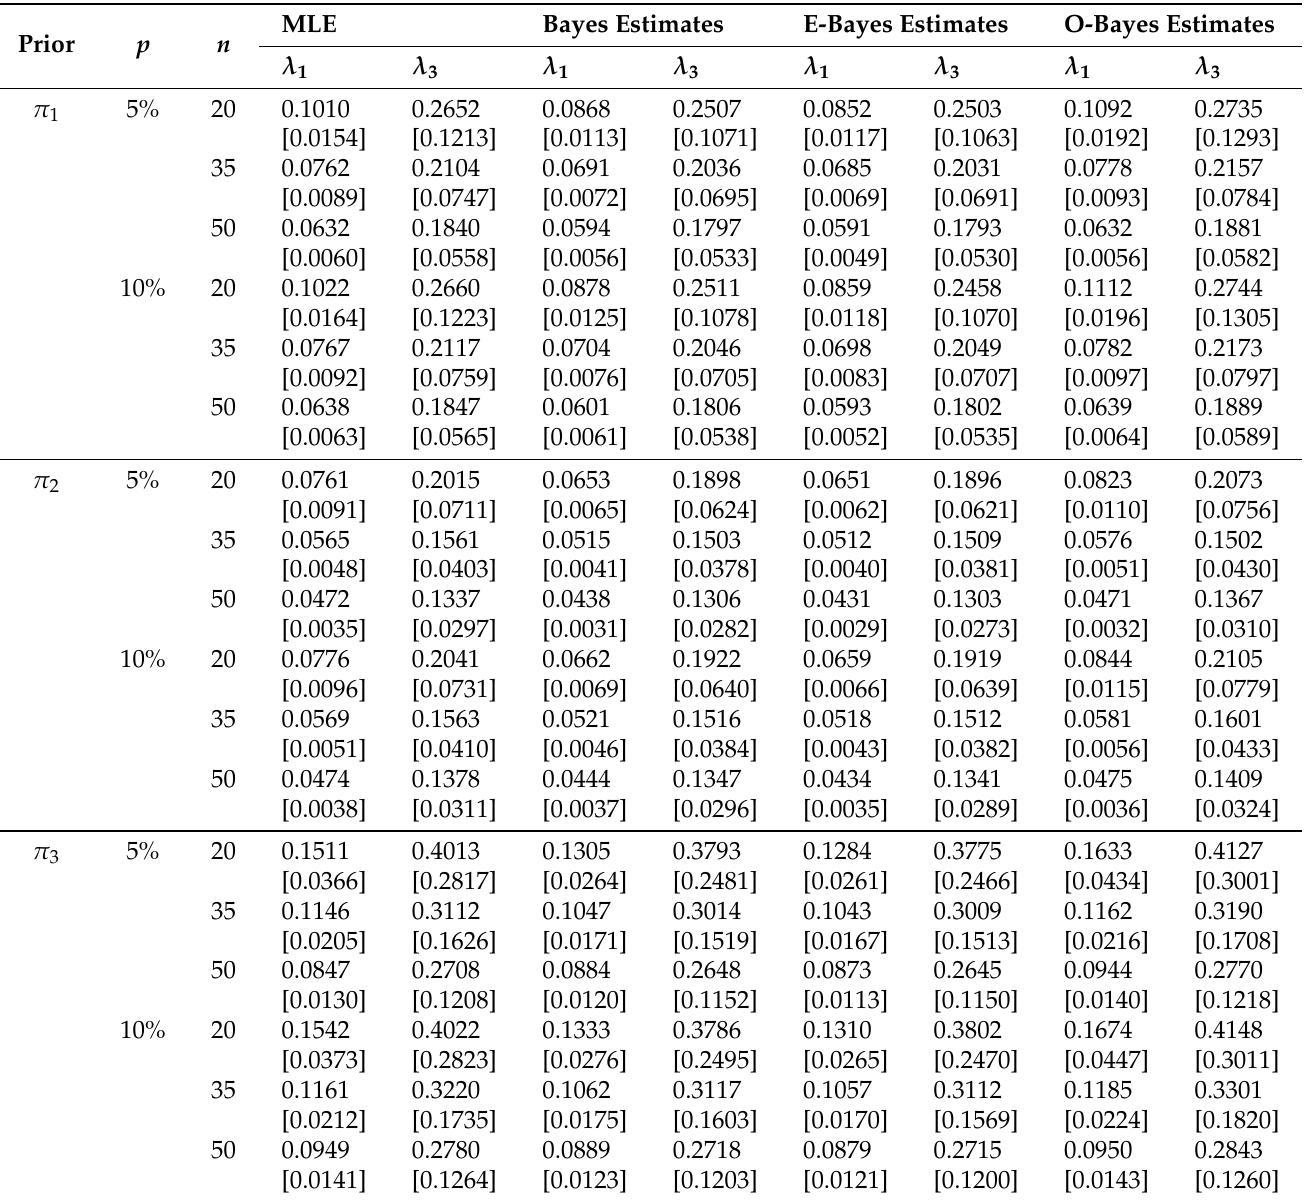
Table 3. ABs and MSEs (within bracket) for MOBE competing risks parameters with ( c 1 , c 2 , c 3 ) = ( 3,2.5,1 ) and τ = R